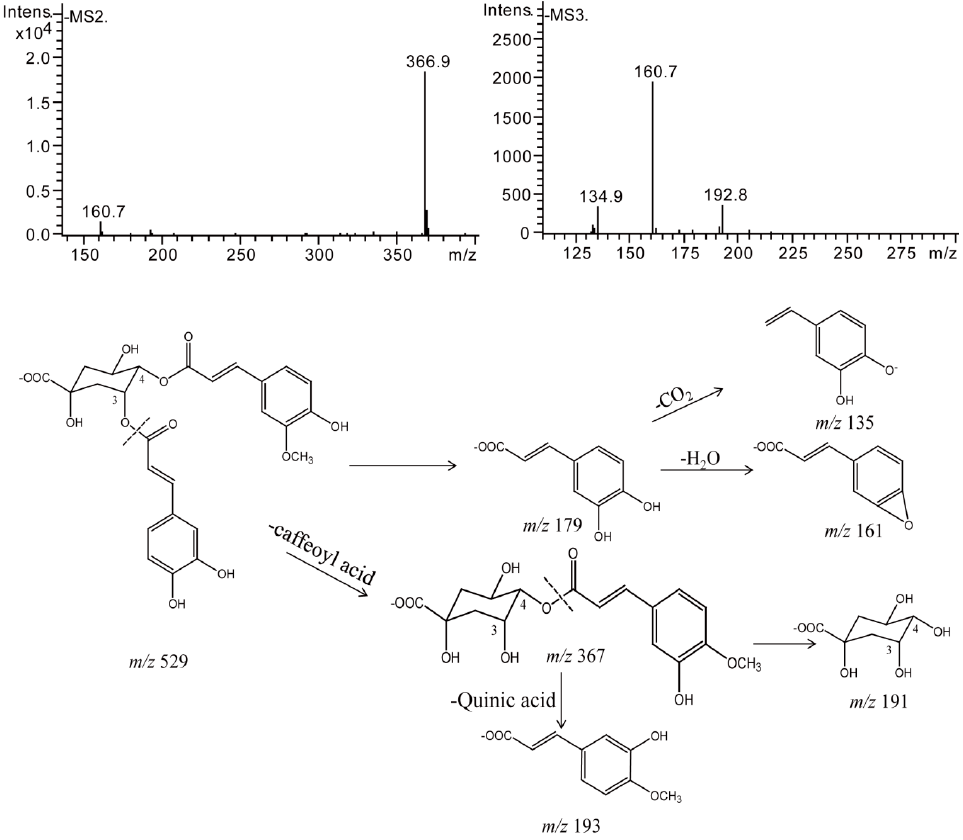
Figure 12. Negative MS n spectra and proposed fragmentation patterns of Methlated 3,4-diCQA.